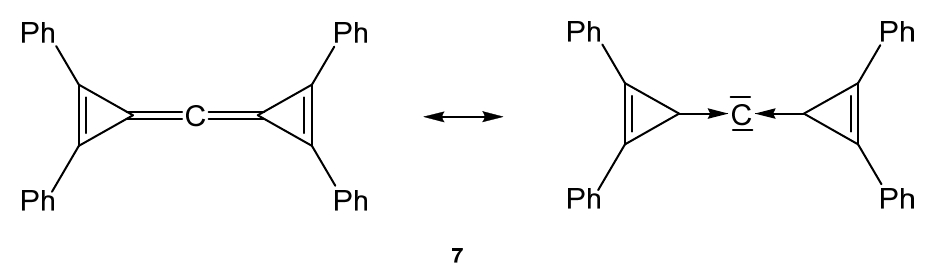
Figure 9. Possible description of the bonding in the carbone 7 .